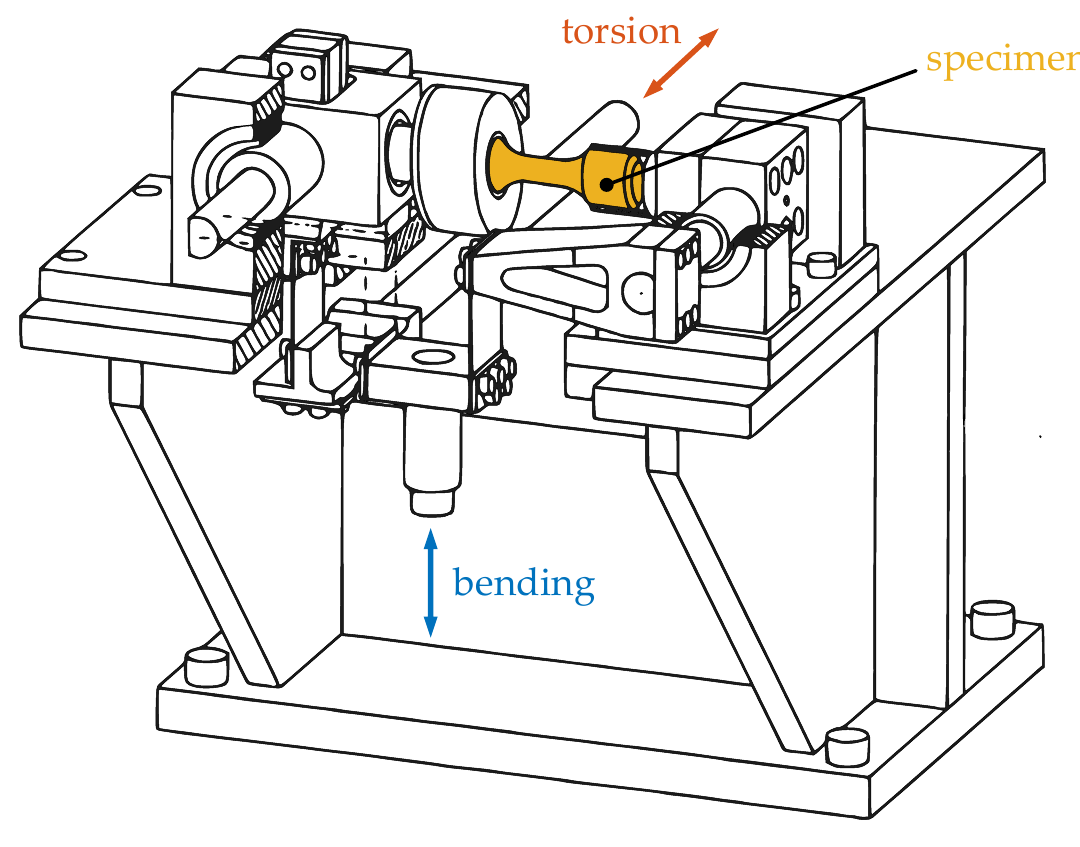
Figure A2. Scheme of testing machine used for load-controlled tests.